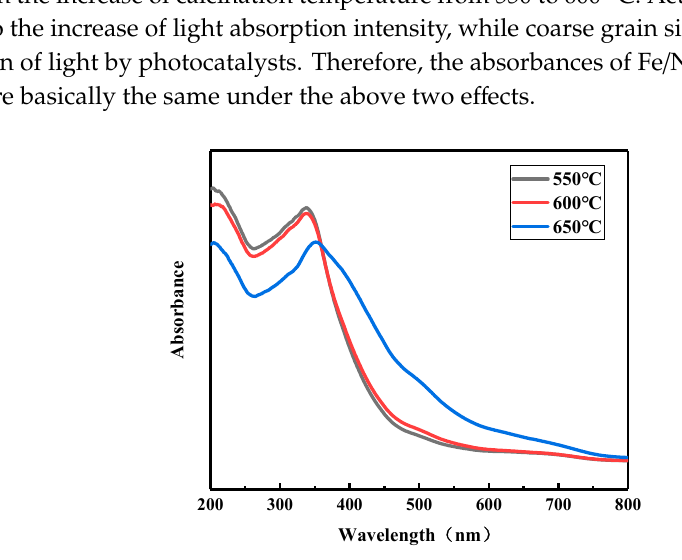
Figure 5. The UV-Vis spectra of Fe/N/Co–TiO 2 after calcination at different temperatures.